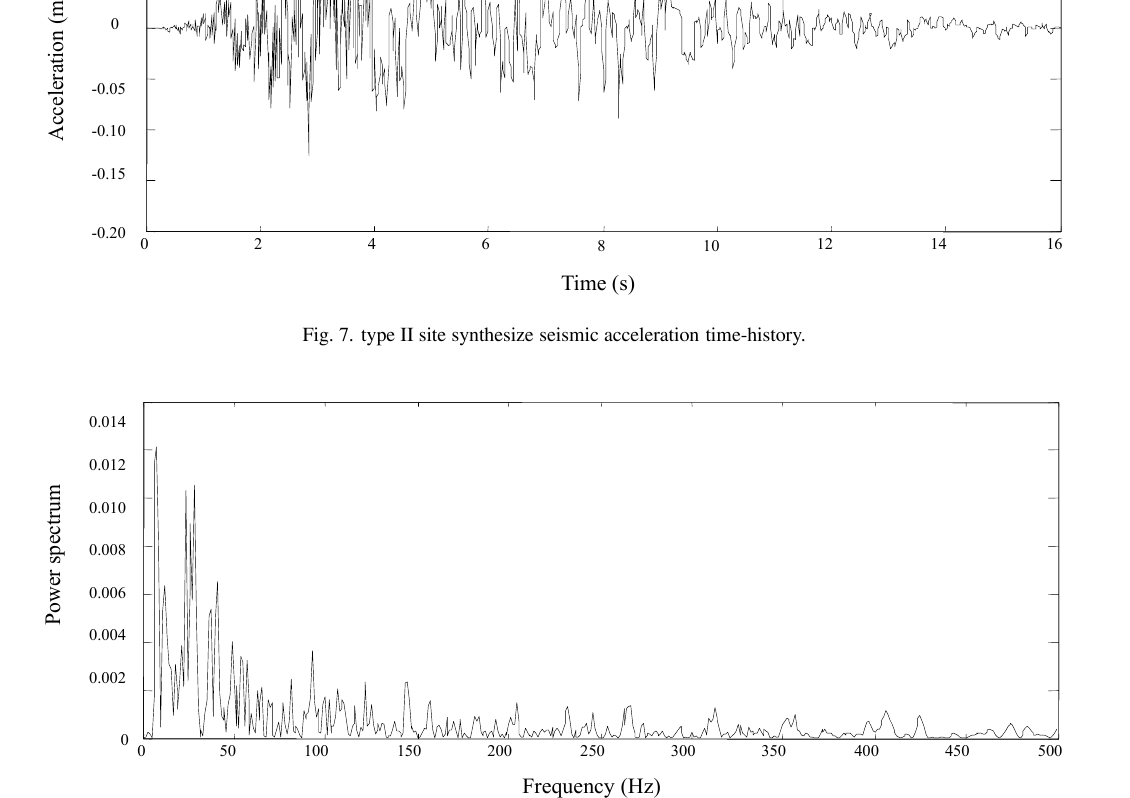
Fig. 8. type II site seismic acceleration power spectrum.